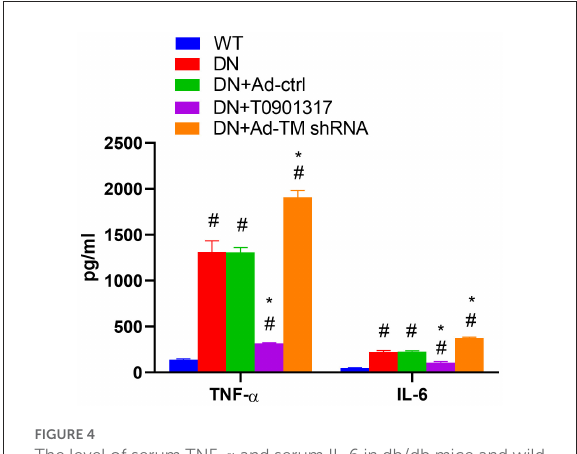
FIGURE4 The level of serum TNF- α and serum IL-6 in db/db mice and wild mice ( n = 6, mean ± SEM). * p < 0.05 compared with the WT group. # p < 0.05 compared with the DN group and Ad-ctrl + DN